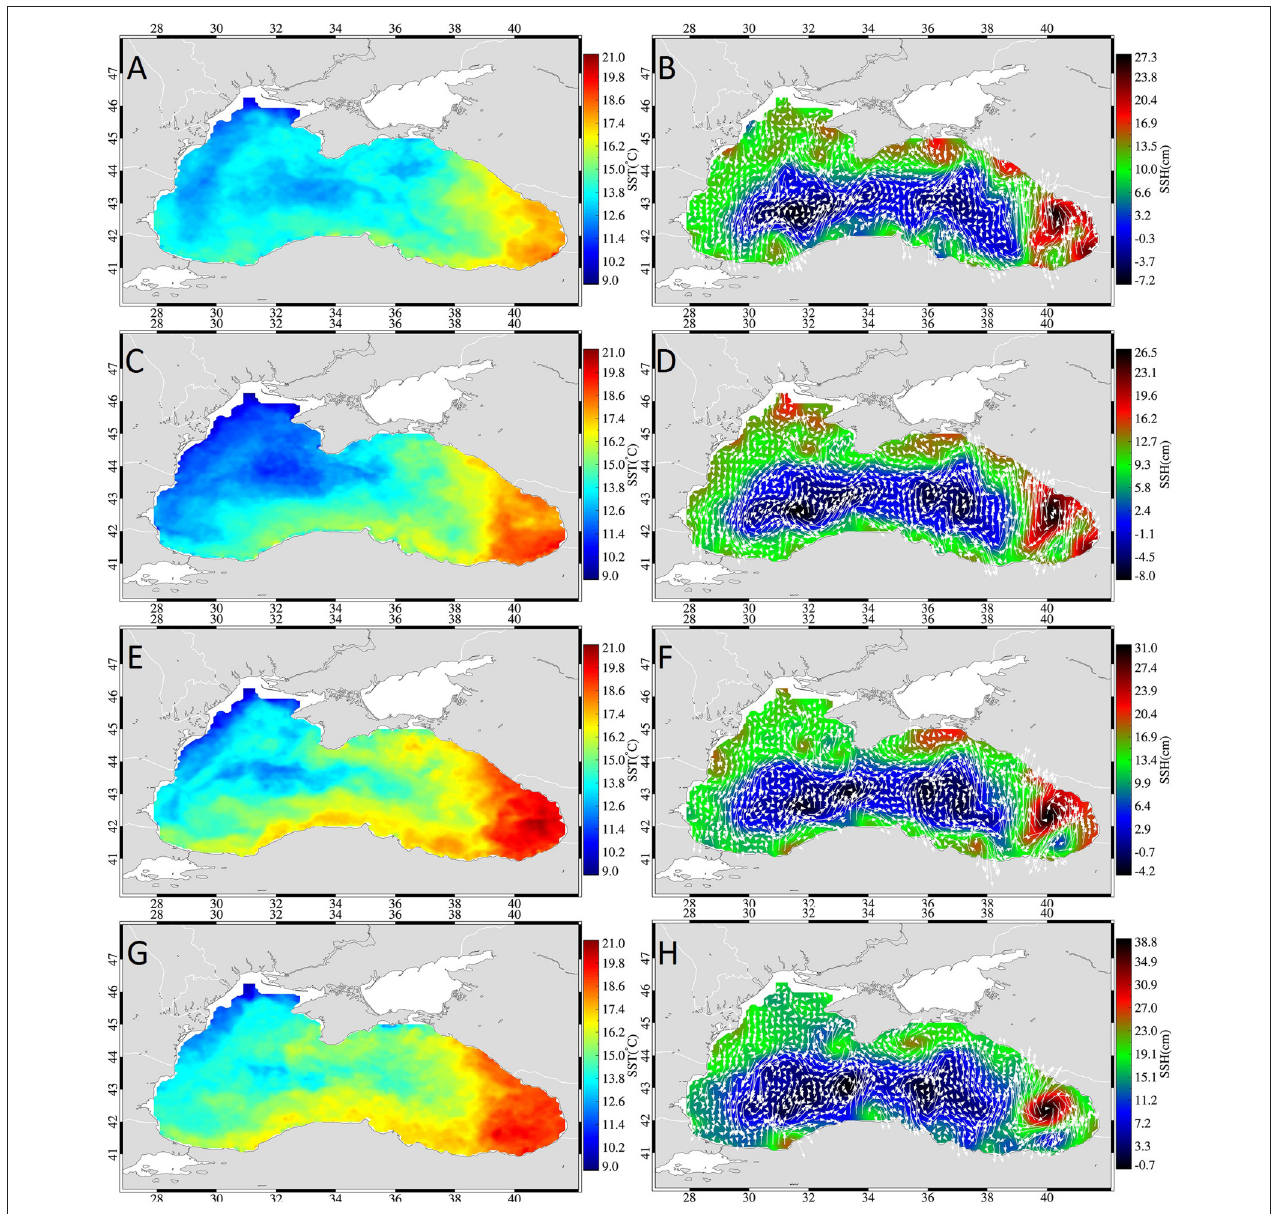
FIGURE 5 | Weekly mean sea surface temperature (left) and sea surface height fields (right) overlaid with geostrophic currents (white arrows) during week 1 (A,B) , 2 (C,D) , 3 (E,F) , and 4 (G,H) of November